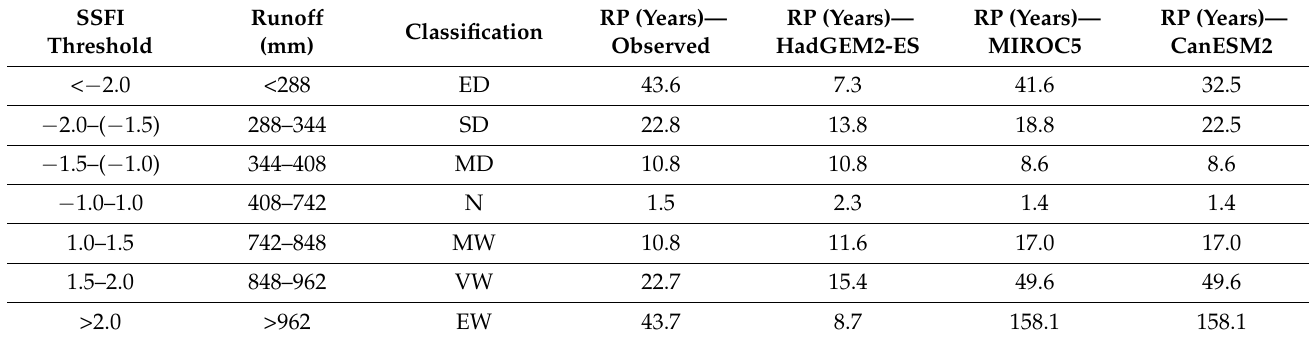
Table 4. Standardized Streamflow Index (SSFI) thresholds and classification, and runoff and return period (RP) from the observed historical series and simulated series from the RCMs forcing the LASH model.